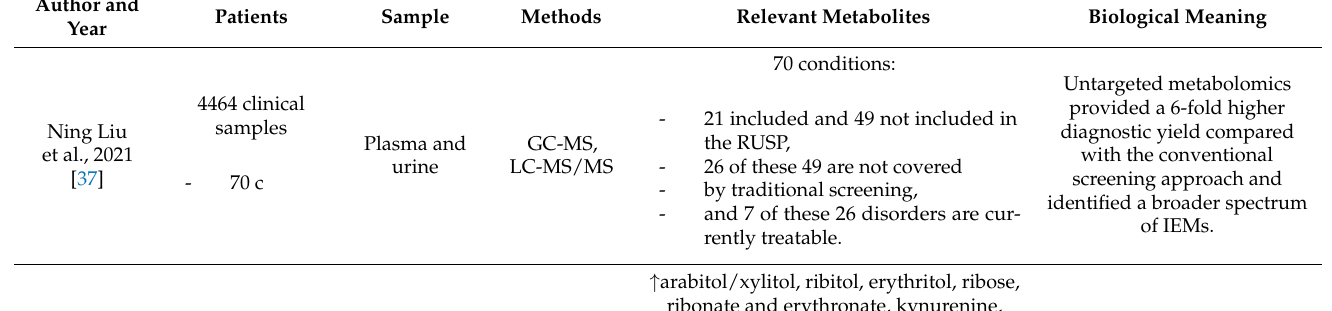
Table 4. Relevant untargeted metabolomics studies applied to the IEMs